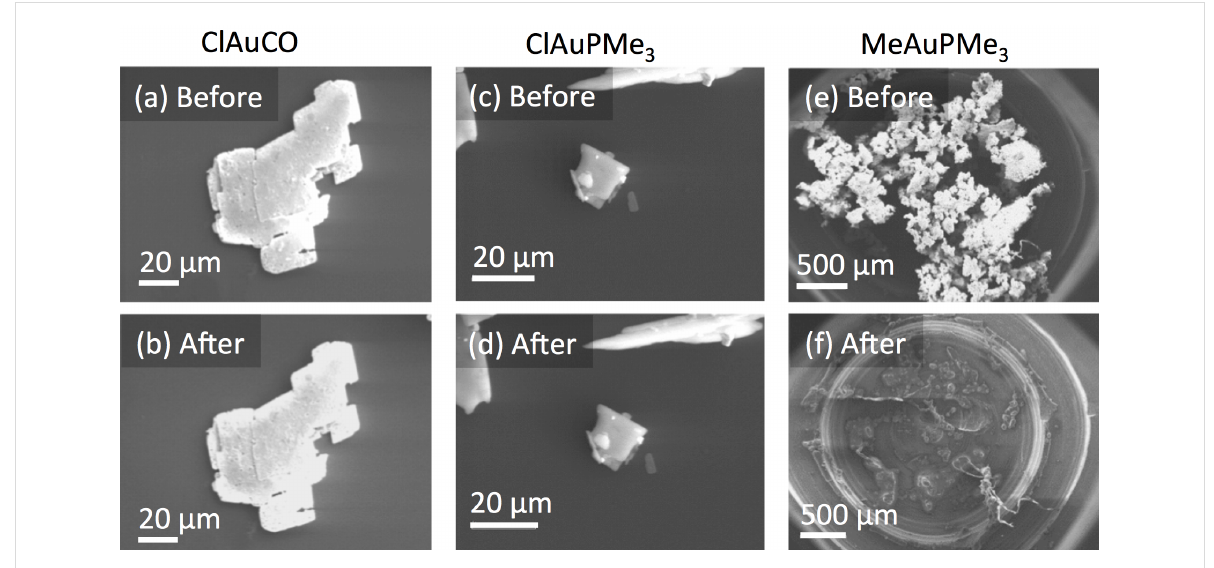
Figure 6: ClAuCO (a) before and (b) after 12 h in vacuum. No changes were observed. For ClAuPMe 3 also no changes were observed (c) before and (d) after 12 h in vacuum. MeAuPMe 3 (e) was found to sublime within about 20 min (f).